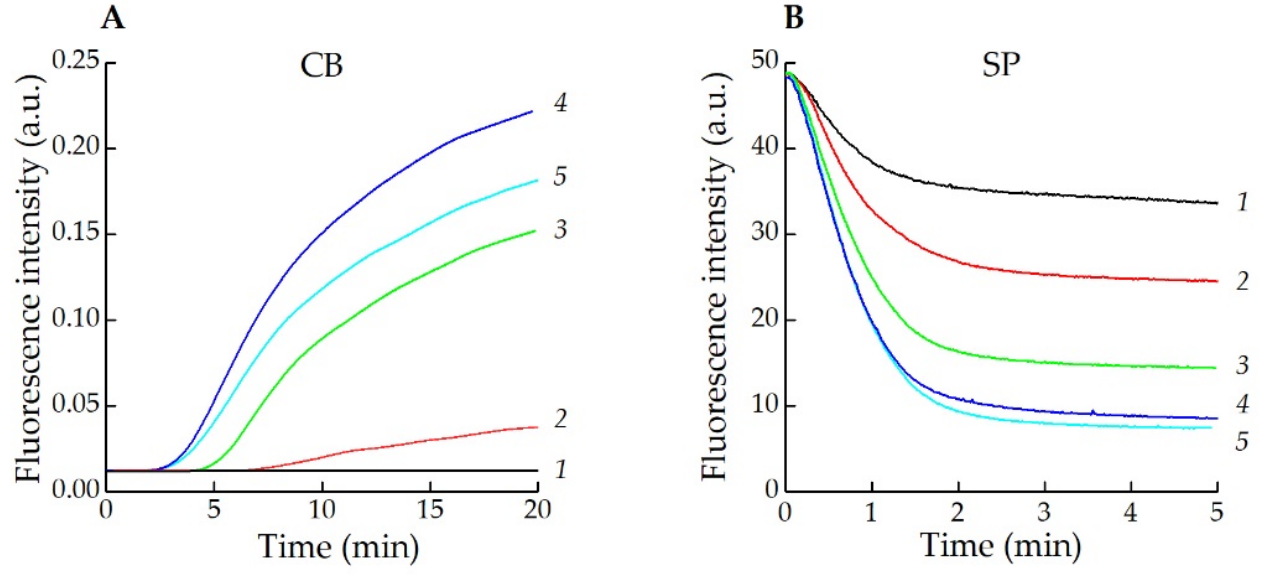
Figure 4. fMLP-induced neutrophil activation. ( A ) Kinetic curves of CB fluorescence reflect the intensity increase. Neutrophils (10 6 cells/mL) were pre-incubated with CB (20 µ M) in the absence (1) and presence (2–5) of cyt b (2.5 mg/L) and different fMLP concentrations were added: 1 µ M (1, 4), 0.25 µ M (2), 0.5 µ M (3), 2 µ M (5) (PBS + 20 mM Tau, pH 7.4, T = 37 ◦ C; λ ex = 460 nm, λ em = 590 nm); ( B ) Typical kinetic curves of scopoletin oxidation. Neutrophils (2 × 10 6 cells/mL) were pre-incubated with 1 µ M scopoletin, 20 µ g/mL HRP, 1 mM NaN 3 and different fMLP concentrations were added: 0.5 µ M (1), 1 µ M (2), 2.5 μ M (3), 5 μ M (4), 10 μ M (5). (PBS, pH 7.4, T = 37 °C; λ ex = 350 nm, λ em = 460 nm).